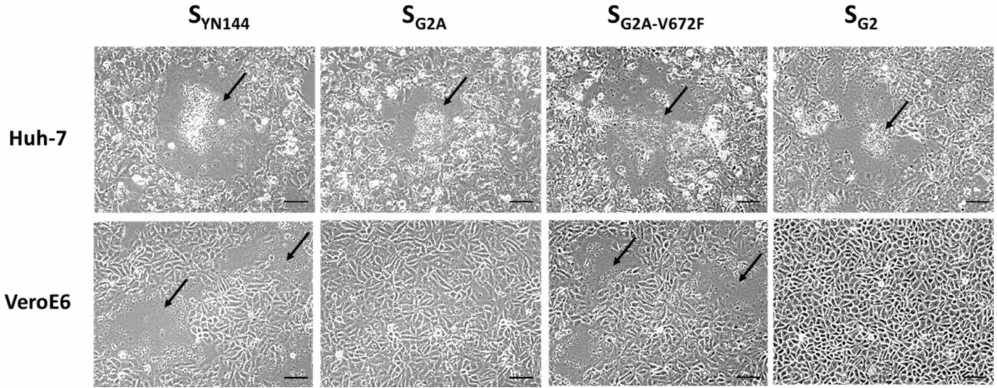
Figure 7. Syncytium formation in Huh-7 and VeroE6 cells expressing PEDV S. Huh-7 and VeroE6 cells were transfected with pCAGGS expressing S YN144 , S G2A , S G2A-V672F , and S G2. Transfected cells were cultured in the presence of trypsin. At 24 hpt, cells were examined for syncytium formation. Arrows denote the formation of the syncytium. Scale 50 µ